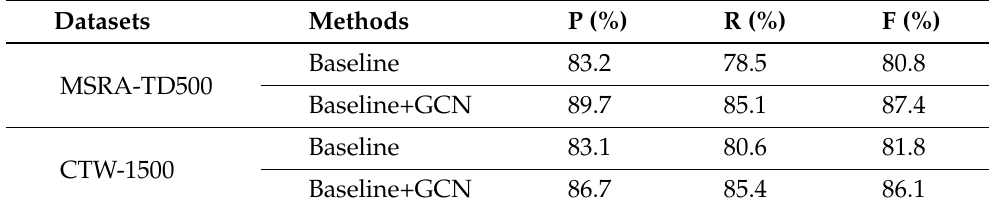
Figure 7. Experimental results of two detection methods. The images in the top row are the detection results obtained directly through the feature extraction network, and the images in the next row are the detection results obtained with the addition of the GCN-based relation inference network. Table 2. Results of ablation experiments of deep relation inference.